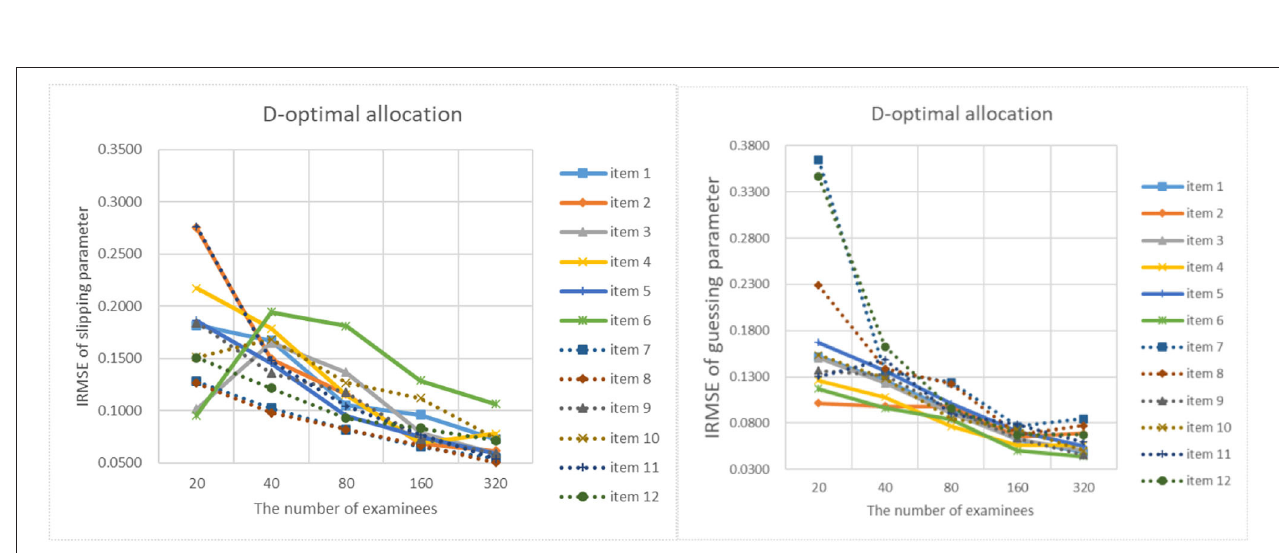
FIGURE 12 | The IRMSE of the D-optimal allocation strategy when the initial value of the item parameter is 0.35.